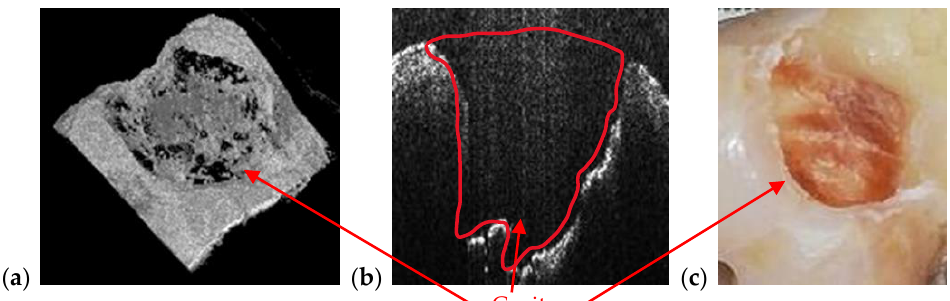
Figure 10. Cavity of a third molar from the second quadrant assessed on ( a ) an OCT 3D reconstruction and on ( b ) an OCT B-scan. Image ( c ) is a photograph of the cavity. Patient R.E., male, age 27 years, diagnosed with a large cavity formed at the border between a dental crown and the tooth’s root. The reason for this cavity is the impossibility of the patient to clean that area because of the gingiva and the inner cheek thickness.